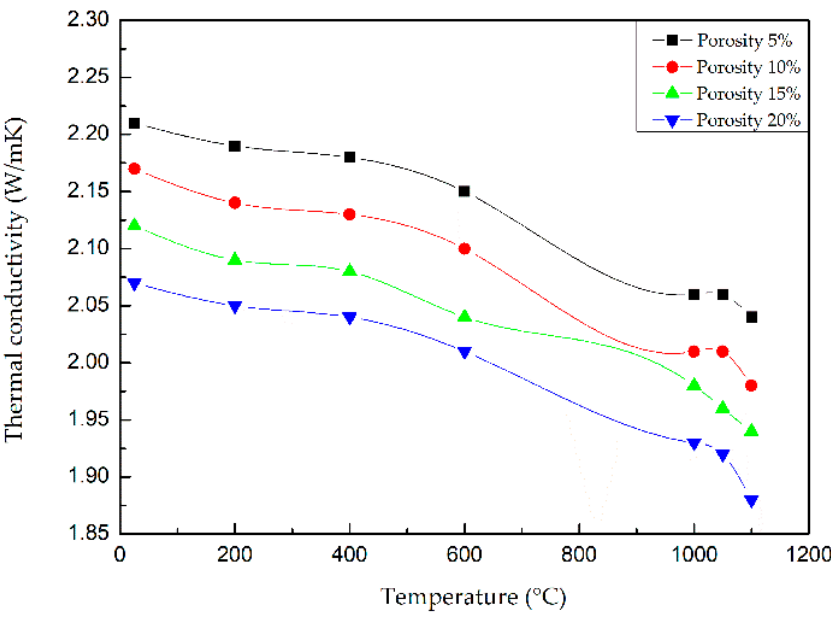
Figure 9. The claculated equivalent thermal conductivity of the top coat in TBCs with various porosities varied at different temperatures.